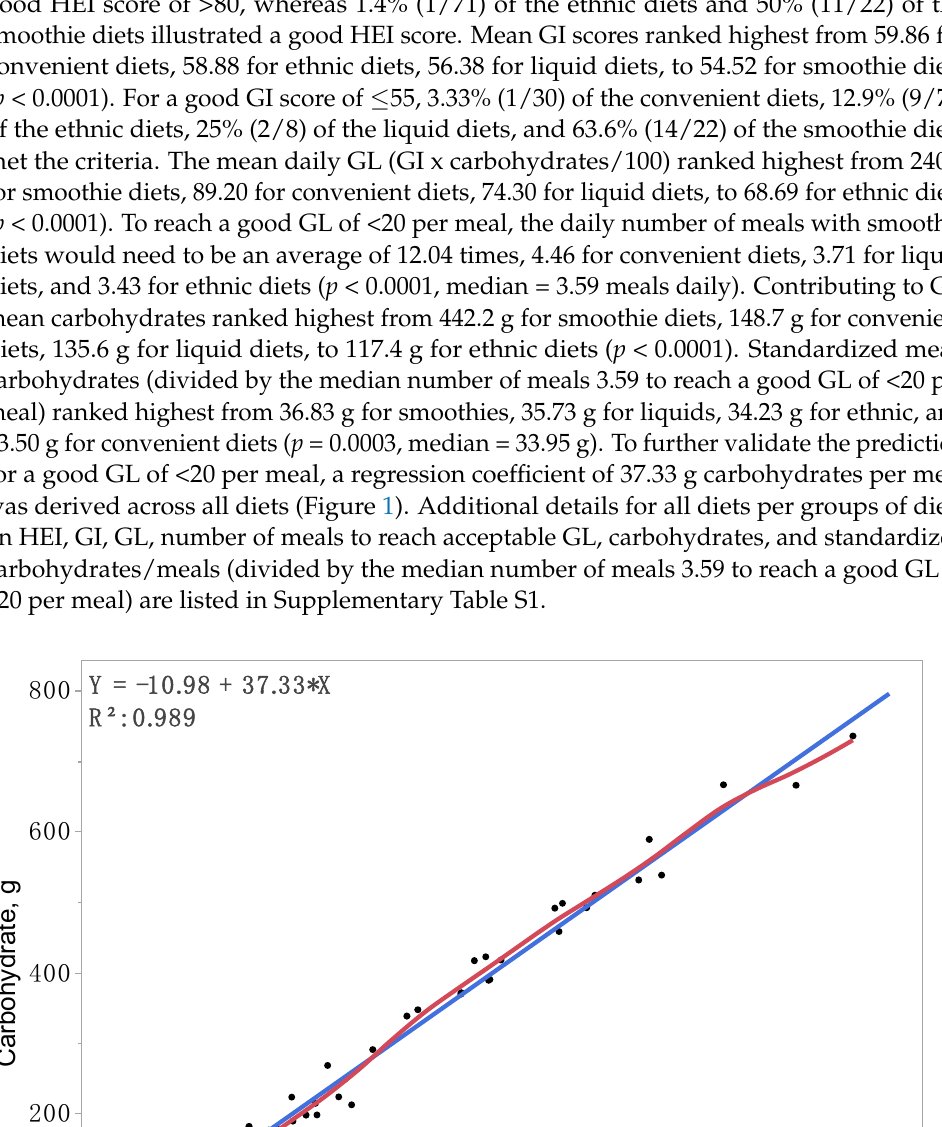
Table 1. Healthy eating parameters per four groups of diets per daily meals ( N = 131).